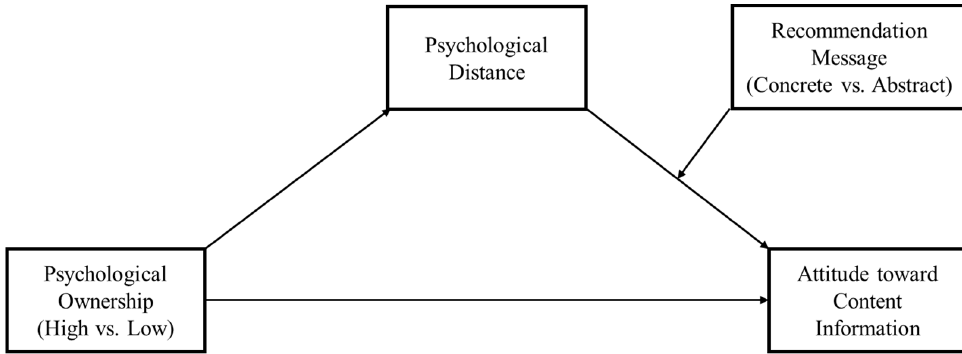
Figure 1. Conceptual research model